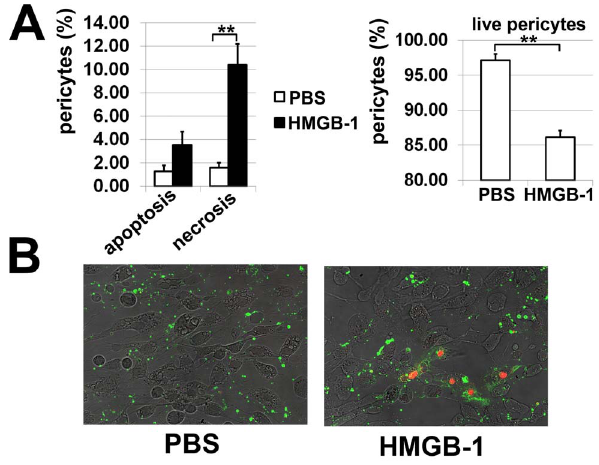
Figure 3. Glia mediates the effect of HMGB-1. ( A ) Primary pericytes co-cultured with glia were treated with HMGB-1 (5 m g/mL, 24 hours). Pericyte survival was assessed using an apoptosis assay kit. All experiments were repeated at least three times (**P , 0.01). ( B ) Representative confocal images.